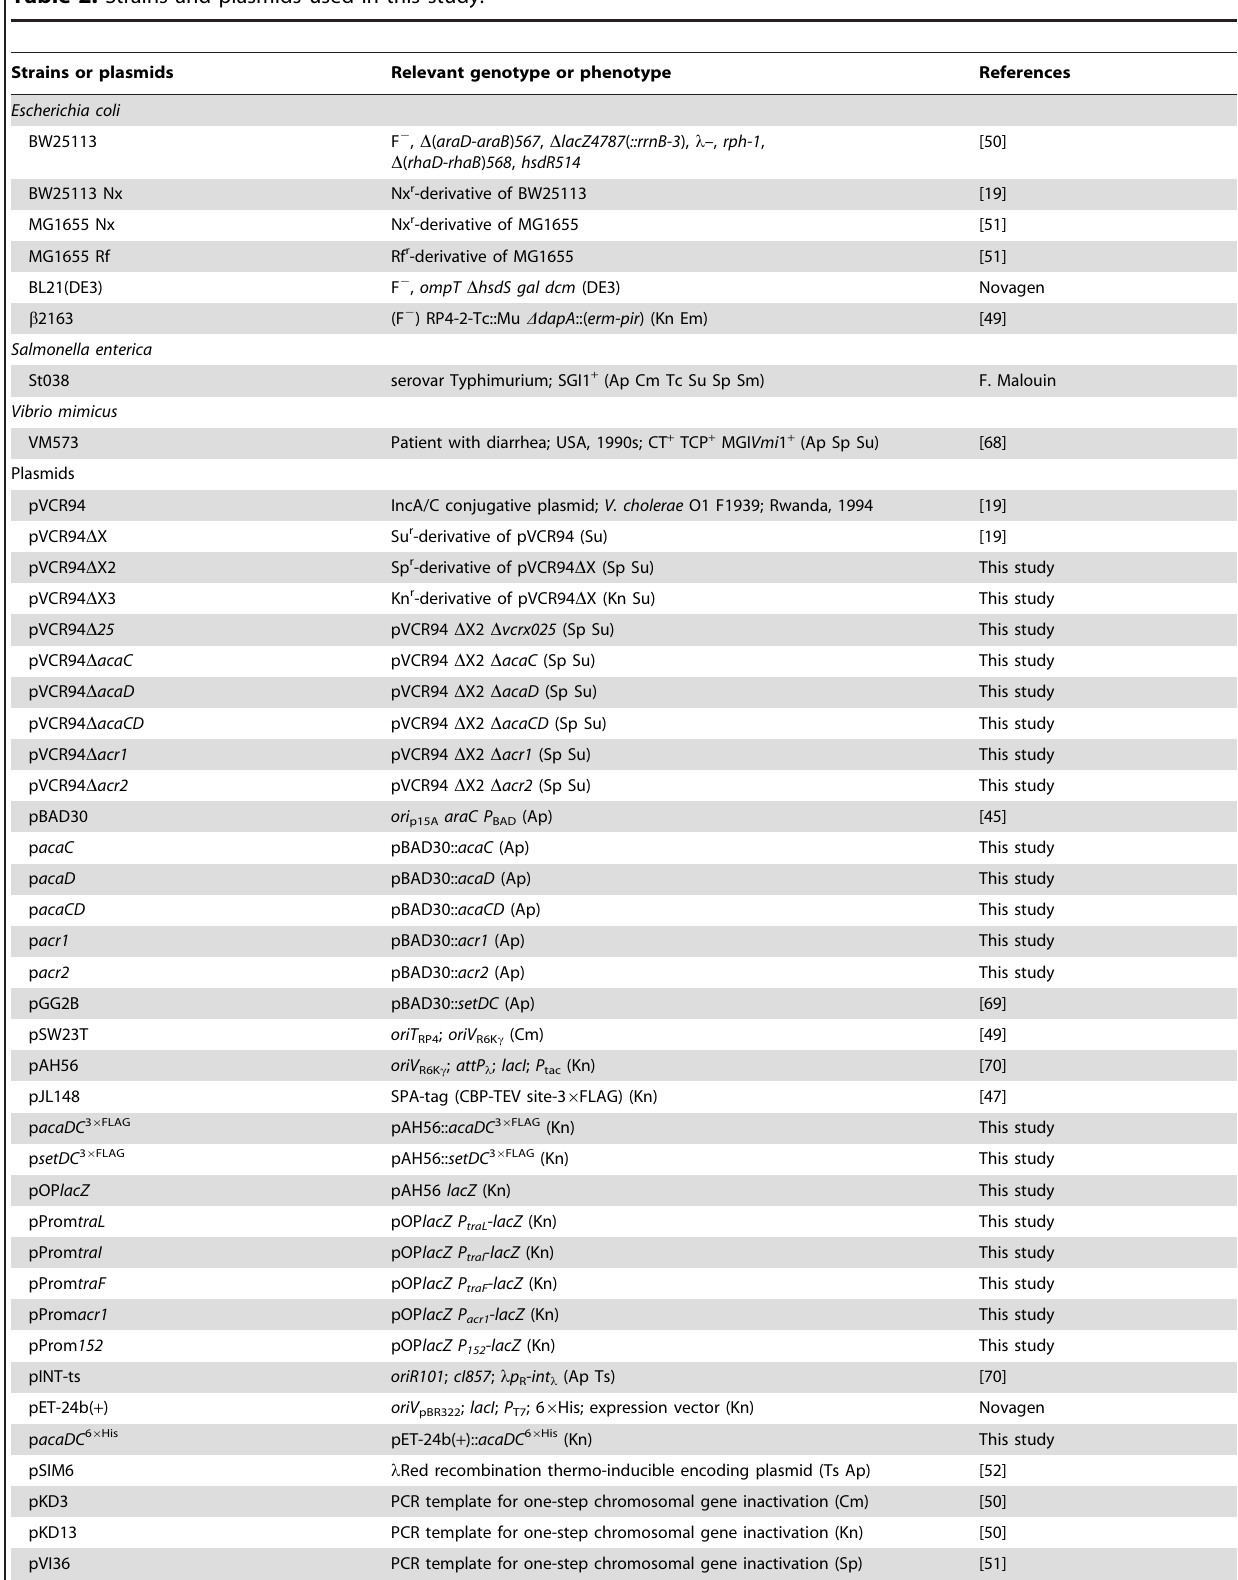
Table 2. Strains and plasmids used in this study.